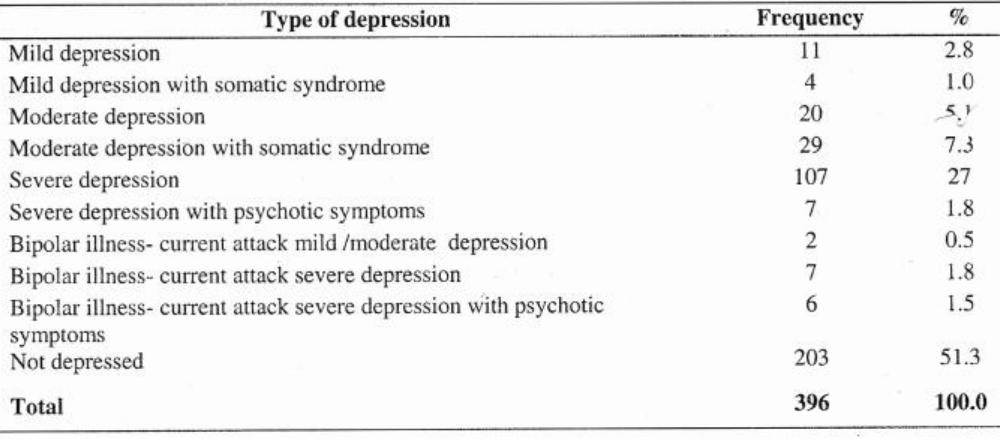
Table 2 : Depressive illness among those who attempted suicides ‘Typeof depression